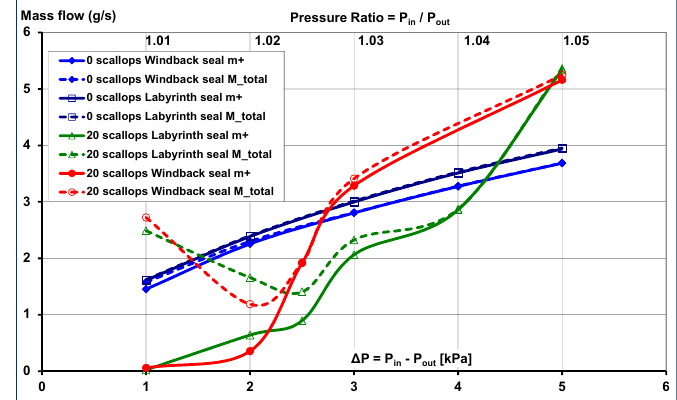
Figure 12. Total and effective mass flow rates for labyrinth and windback seal with and without rotor scallops at 15,000 rpm, s = 0.3 mm as a function of the pressure ratio. Scallops initiate backflow which is considerable at small pressure ratios.